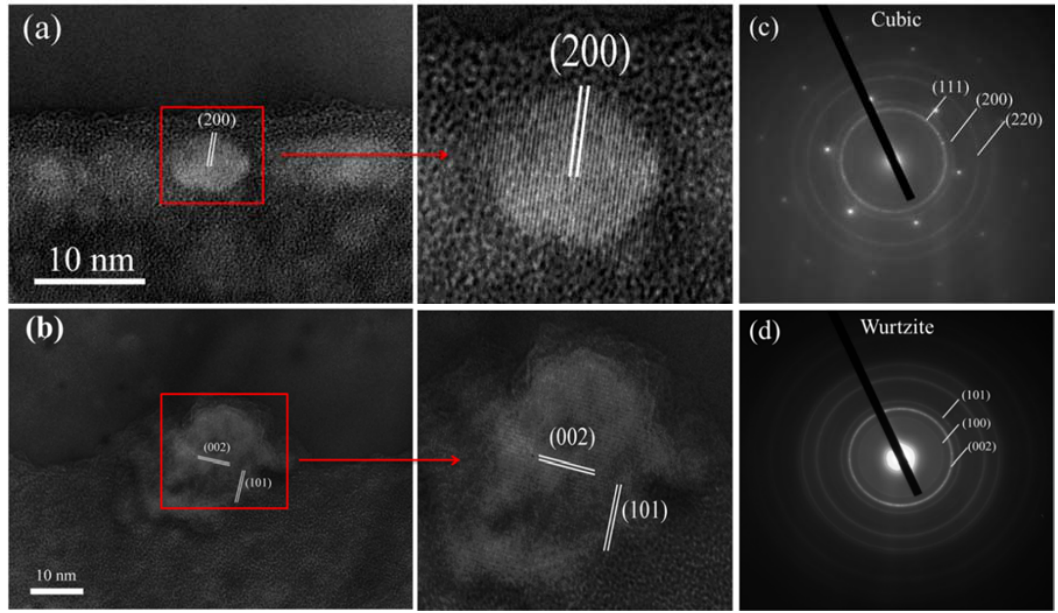
Figure 6. Cross ‐ section HRTEM images of a single GaN nanodot: Sample with pre ‐ nitridation C1 ( a ) Figure 6. Cross-section HRTEM images of a single GaN nanodot: Sample with pre-nitridation C1 ( a ) and sample without pre ‐ nitridation C2 ( b ); Selective ‐ area diffraction patterns of GaN nanodots: and sample without pre-nitridation C2 ( b ); Selective-area diffraction patterns of GaN nanodots: sample sample C1 ( c ), and sample C2 ( d ). C1 ( c ), and sample C2 ( d